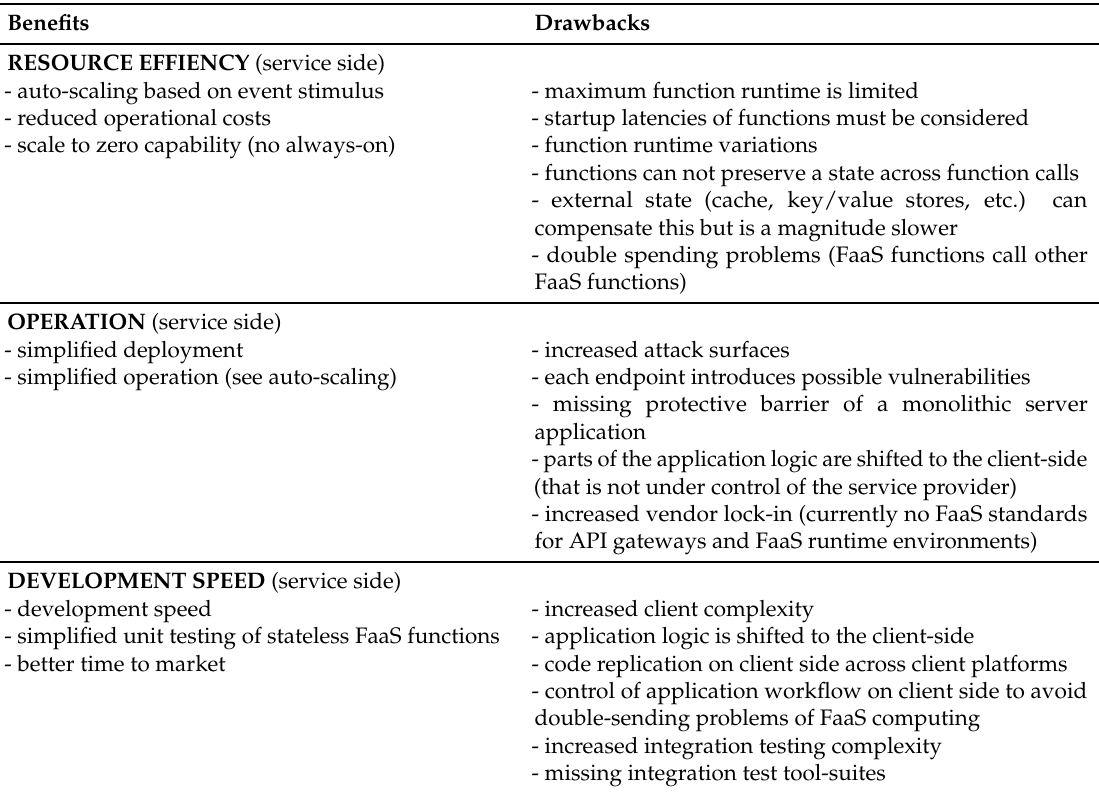
Table 4. Serverless architecture benefits and drawbacks (mainly compiled from